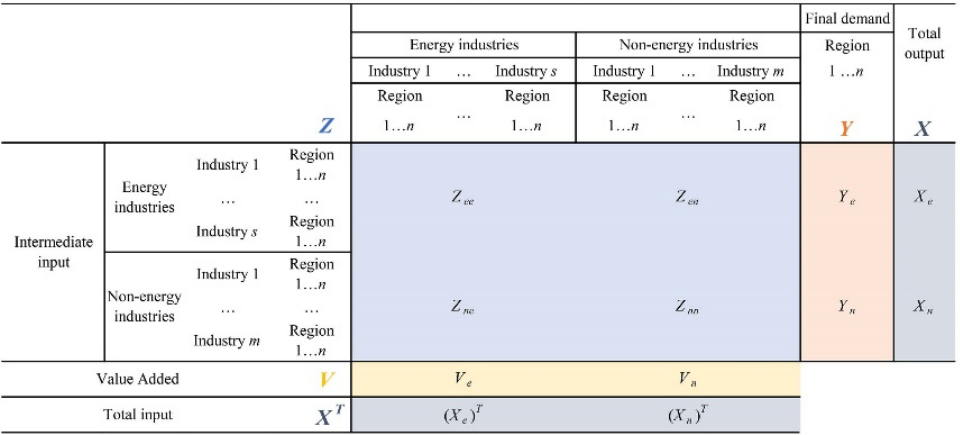
Figure A1. Structure diagram of the GMRIO table.